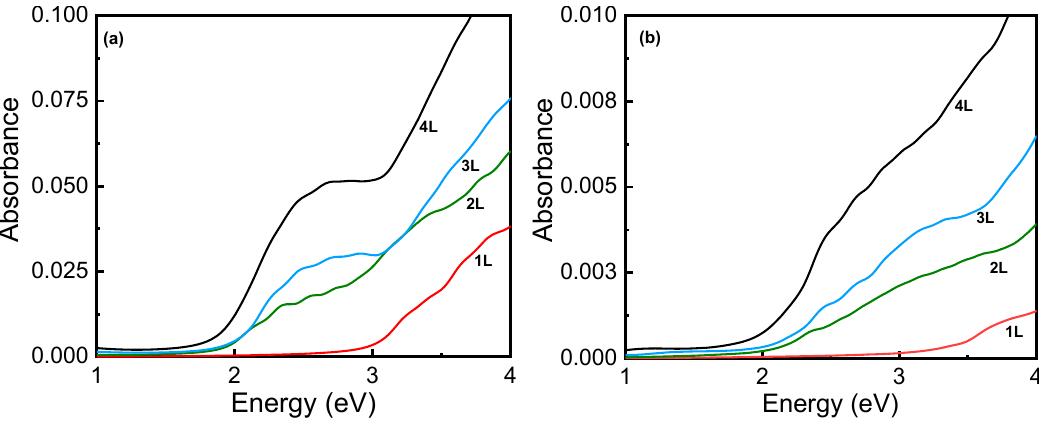
Figure 3. Multilayer borophene: ( a ) X and ( b ) Y (in-plane polarization) component of the electromagnetic field for absorbance as a function of the number of layers (1L-monolayer, 2L-AA bilayer, 3L-AAA trilayer, and 4L-AAAA quad layer).